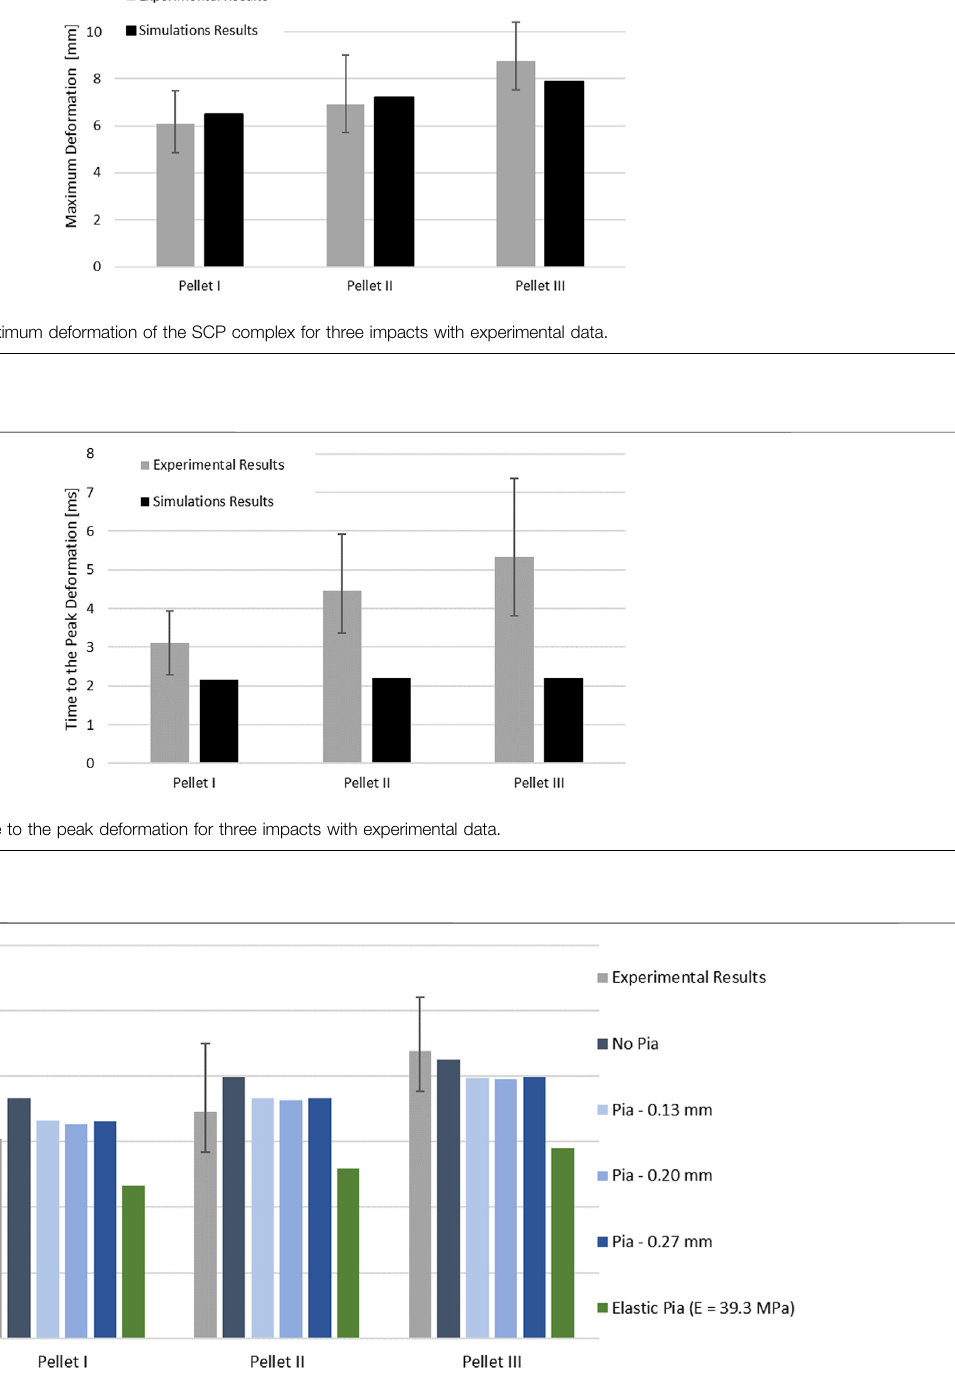
FIGURE 10 | Variation of the peak deformation in the impact model for three pellets with respect to varying thickness of the pia mater.